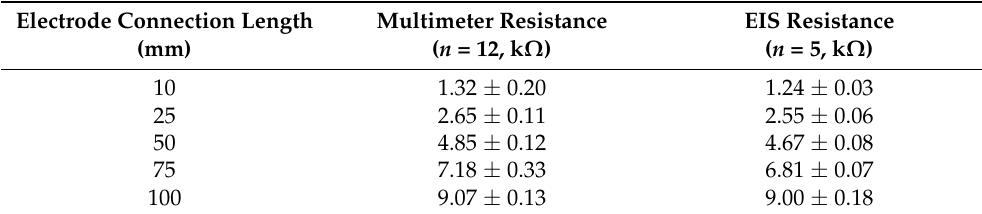
Table 2. Effect of changing the connection length on the resistance measured through a multimeter and electrochemical impedance